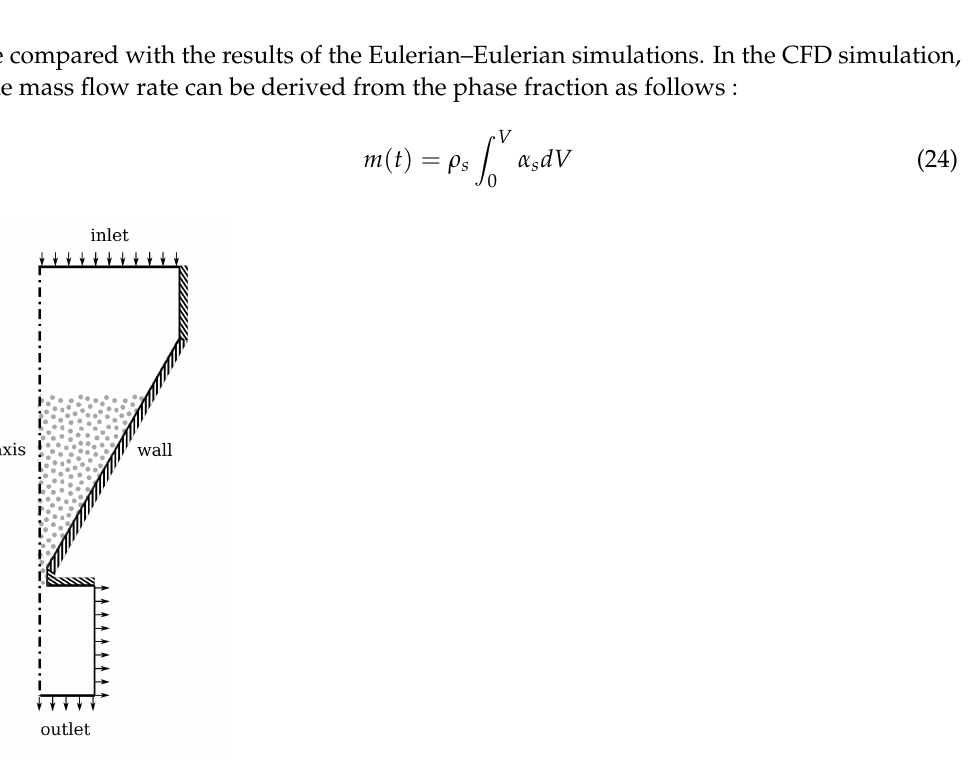
Figure 1. Basic geometry and boundary conditions for the Hallflow case (2D representation). Note that this is a conical shape hopper; the full 3D geometry is constructed from rotation around the central